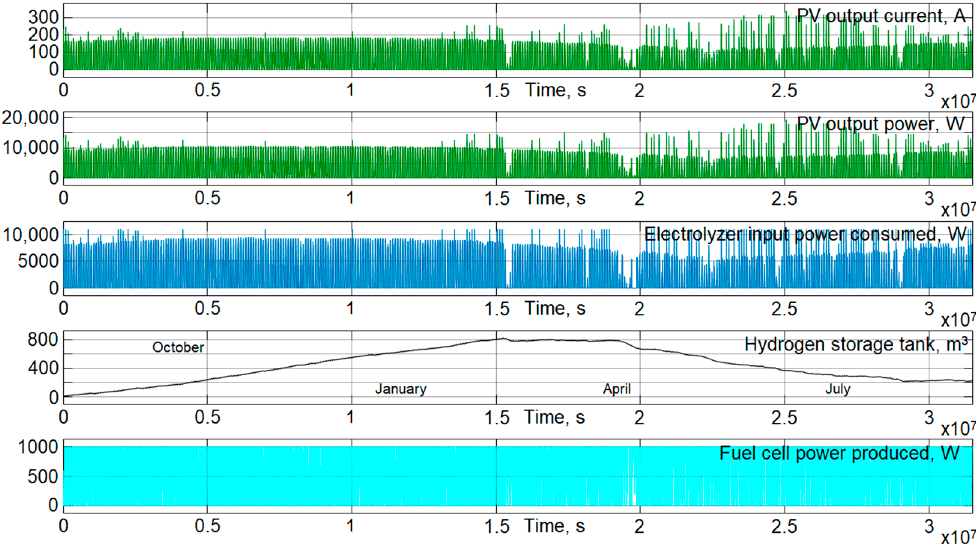
Figure 21. The result of the simulation and calculation of the required hydrogen tank capacity for the location Gnaraloo, Australia.